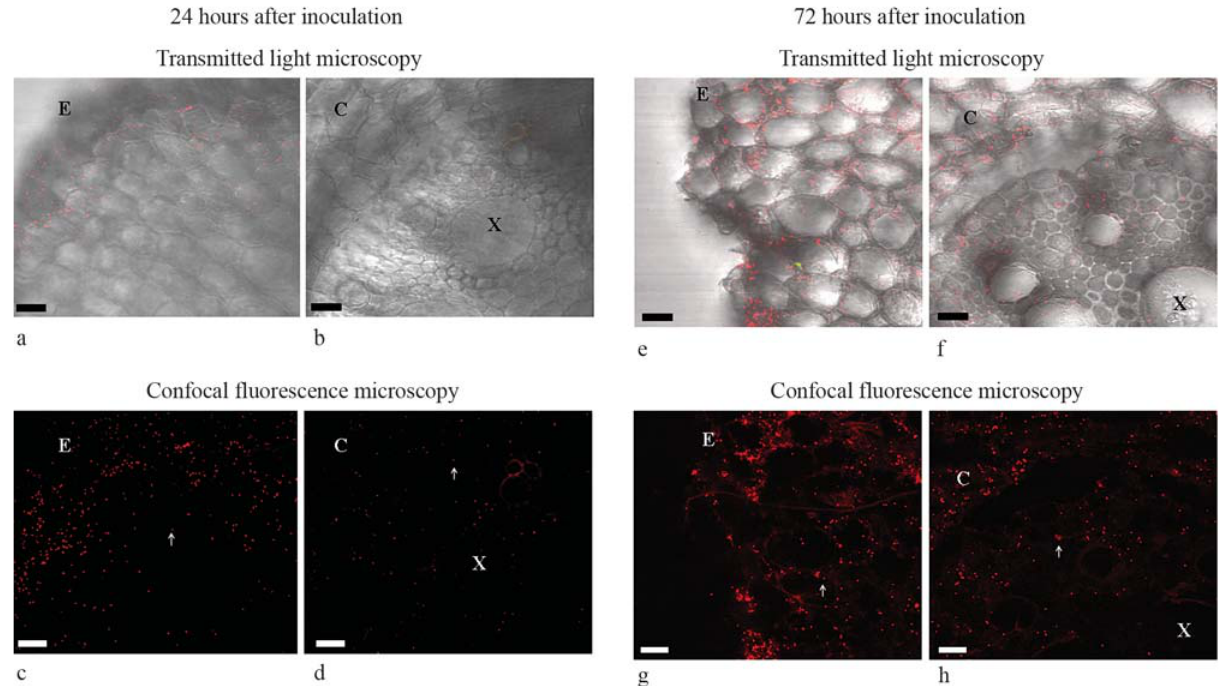
Figure 2 - Transmitted light and confocal fluorescence microscopy of a cross-section of maize root 24 (a to d) and 72 h (e to h) after inoculation with Herbaspirillum seropedicae strain RAM4. The images were recorded in two different regions of the cross-section: the epidermis (a, c, e and g) and the central cylinder (b, d, f and h). Key: E = epidermis; X = xylem vessels; C = cortex. Arrows indicate the fluorescent bacteria. Bars = 50 μ